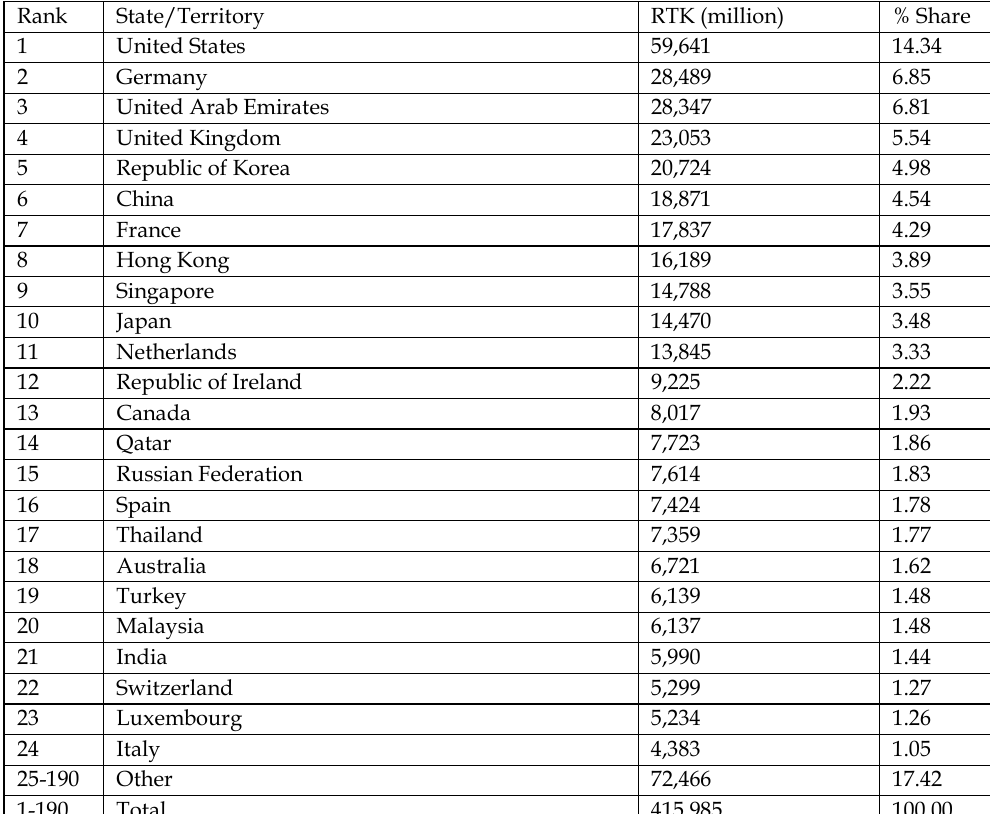
Table 5. States Ranking according to the share of global international air traffic revenue tonne kilometres (RTK) in